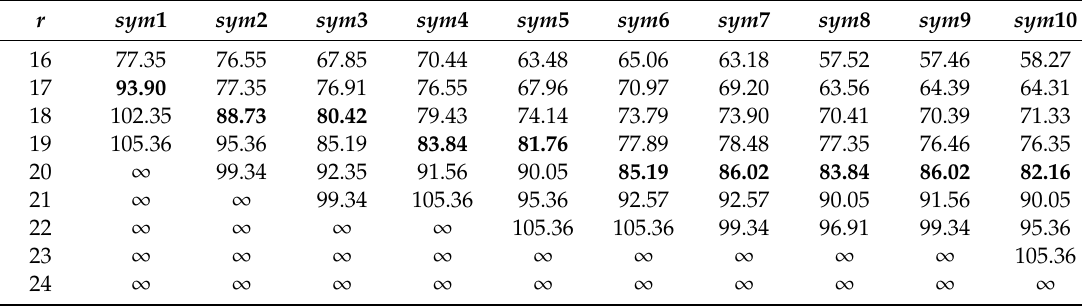
Table 6. Calculation results ( PSNR , dB) of 3D medical images (with 16 BPC) DWT by using bit-width r of symlets filters coe ffi